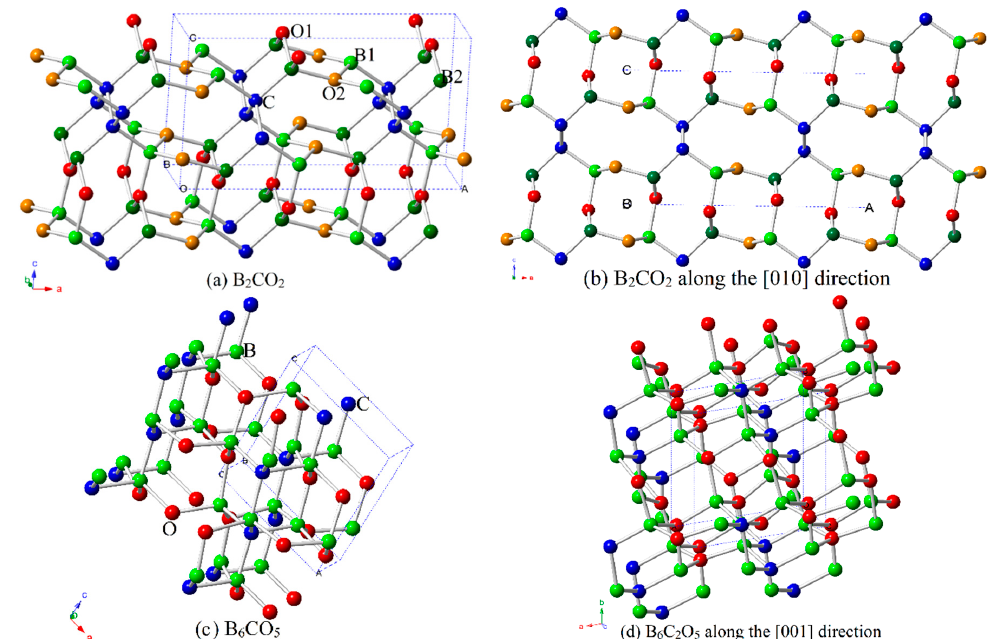
Figure 1. Lattice structure of B 2 CO 2 ( a ); and along the [010] direction ( b ); and lattice structure of B 6 C 2 O 5 ( c ); and along the [001] direction ( d ). Table 1. Calculated lattice parameters of B 2 CO 2 , B 6 C 2 O 5 and other B-C-O compounds.